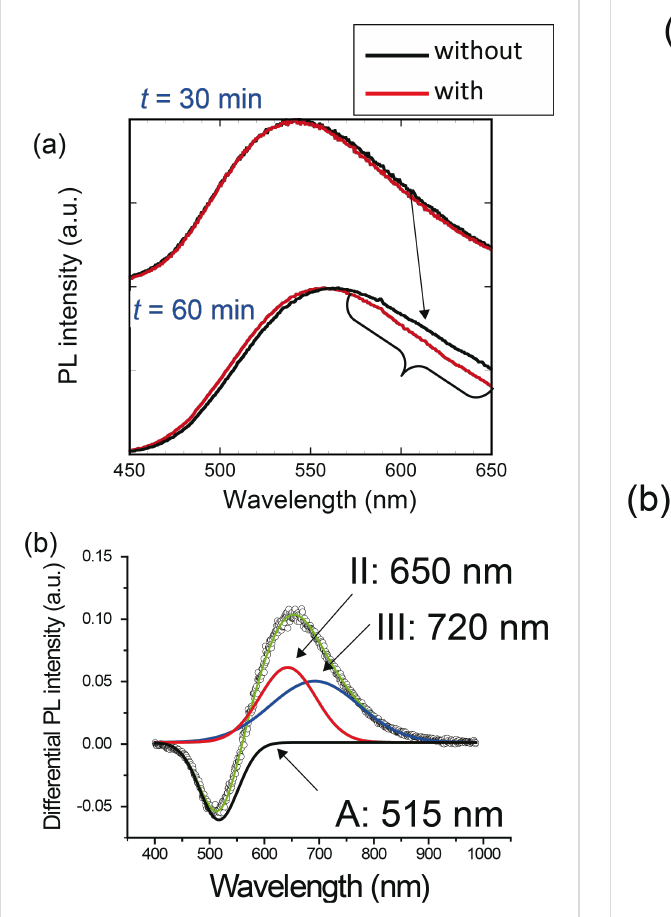
Figure 3: (a) PL spectra obtained with 593 nm light ( λ 1 ) as functions of the growth time, t . Black solid lines: spectra of nanocrystals obtained without light irradiation, PL without . Red solid lines: spectra of nanocrys- tals obtained with light irradiation, PL with . (b) Differential PL spectra calculated from the spectra obtained (after t = 60 min) with irradiation (red line in (a)) and without irradiation (black line in (a)).